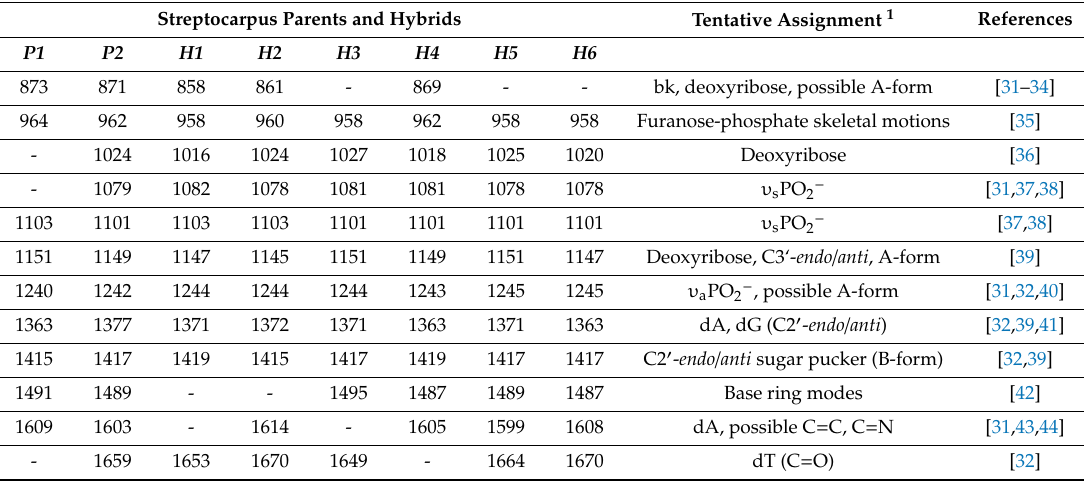
Table 4. Peak positions (cm − 1 ) and tentative assignments of FT-IR absorbance bands for DNA from the Streptocarpus P1 × P2 parental cross and their corresponding hybrids.